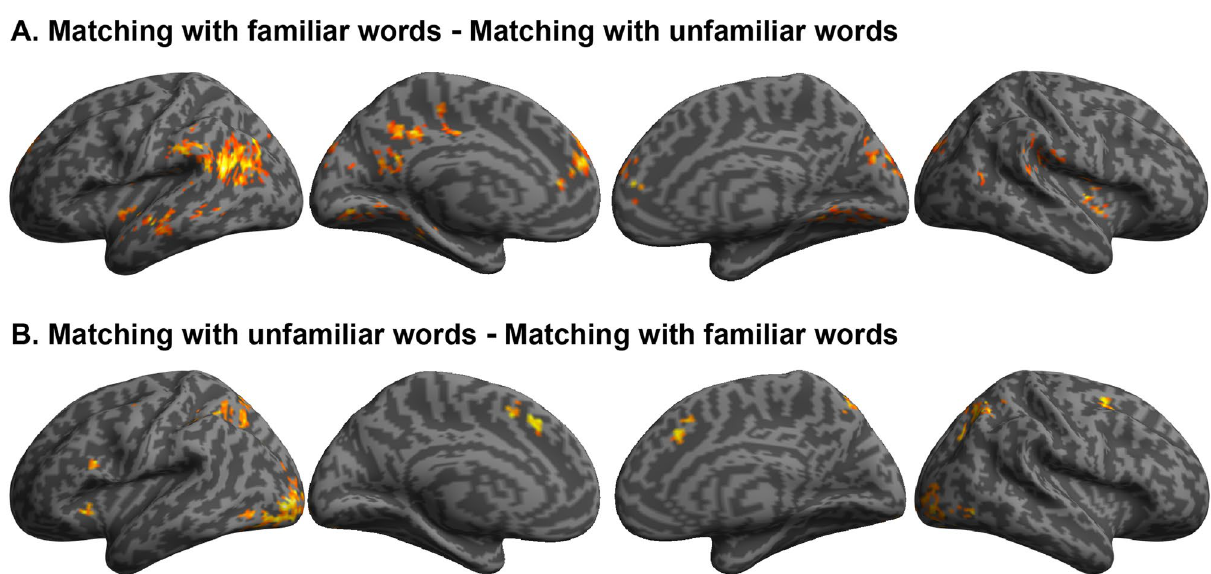
Figure 3. Main effects of familiarity (familiar conditions–unfamiliar conditions) in the matching task. The group-level activation revealed by the contrast of familiar sound symbolic words against unfamiliar words and by the opposite contrast was superimposed on a surface-rendered T1-weighted MRI of an individual unrelated to the study. No significant interaction with matching was observed. The statistical threshold for the spatial extent test was set at p < 0.05; family-wise error (FWE) corrected for multiple comparisons over the whole brain when the height (cluster-forming) threshold was set at p < 0.001 bilateral insula and medial superior frontal gyrus. Additionally, the same contrast revealed activation in the bilateral inferior frontal gyrus, left orbitofrontal cortex, bilateral anterior insula, right cingulate gyrus, and right cerebellum (Fig. 2, Supplementary Table 3). A significant effect was not observed in the posterior temporal regions (e.g., middle temporal gyrus). The opposite contrast revealed no significant activation. Main effects of familiarity. The contrast of conditions with familiar words against conditions with unfamiliar words revealed regions of significant activation bilaterally in the angular gyrus, cuneus, insula, lingual gyrus, middle temporal gyrus, precuneus, superior frontal gyrus, superior occipital gyrus, superior temporal gyrus, and supramarginal gyrus. Moreover, the same contrast showed activation in the left cingulate gyrus, left fusiform gyrus, left parahippocampal gyrus, left postcentral gyrus, left precentral gyrus, right middle occipital gyrus, and right parietal operculum (Fig. 3A, Supplementary Table 4). The opposite contrast revealed regions of significant activation in the bilateral angular gyrus, bilateral inferior occipital gyrus, bilateral middle frontal gyrus, bilateral middle occipital gyrus, bilateral superior frontal gyrus, bilateral superior occipital gyrus, bilateral superior parietal lobule, left inferior frontal gyrus, left insula, left supramarginal gyrus, right precuneus, and bilateral cerebellum (Fig. 3B, Supplementary Table 4). Interaction between matching and familiarity effects. No significant activation was observed.